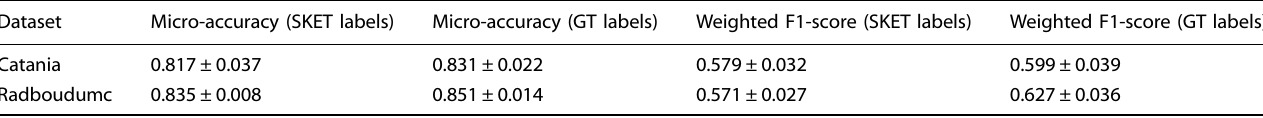
Table 3. Results of the CNN on the fi ve classes WSI classi fi cation task on the SKET mislabeled samples, considering both the models trained with automatically and manually labeled WSIs.